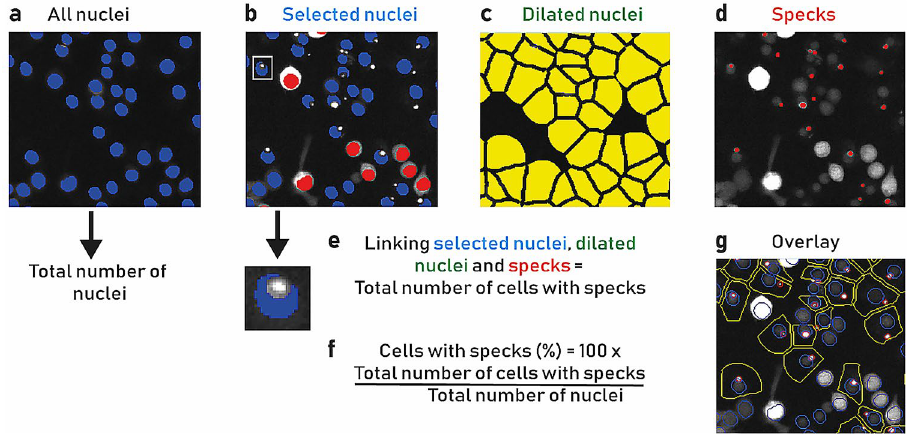
Figure 2. Speck image analysis pipeline. ( a ) All nuclei (blue) were segmented, and the total number of nuclei were counted. ( b ) Very bright mCherry fluorescent cells were removed from the analysis to avoid incorrect speck segmentation. This was achieved by measuring the mCherry intensity in the nucleus minus spot masks (see inset) and rejecting cells above a fixed intensity level threshold (red) and selected nuclei (blue) were retained. ( c ) Nuclei were dilated (yellow) to give a pseudo cell region where specks were counted. ( d ) Specks were segmented. ( e ) The selected nuclei, dilated nuclei and specks were linked together to yield the total number of cells with specks. ( f ) The final calculation consisted of the ratio between the total number of cells with specks and the total number of nuclei and multiplying it to 100 to calculate the percentage of cells with specks. ( g ) Example segmentation overlay after analysis, nuclei (blue), cells (yellow) and specks (red).